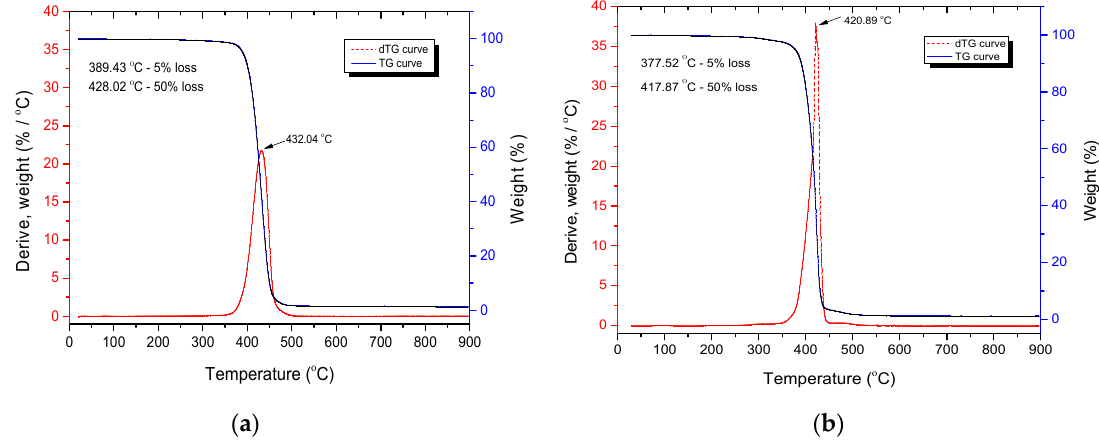
Figure 3. TG and DTG curves of ( a ) neat PCL and ( b ) PCL/PLA/CF 100/0/3.0 blend.